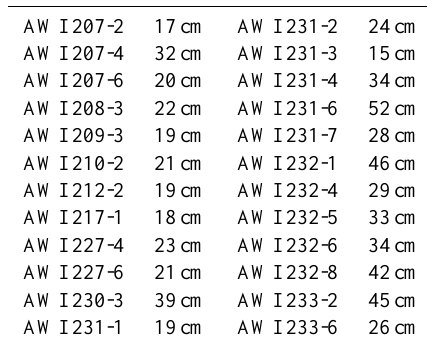
Table 3. RMS-deviations of ice draft in the winter months of data corrected by two di ff erent